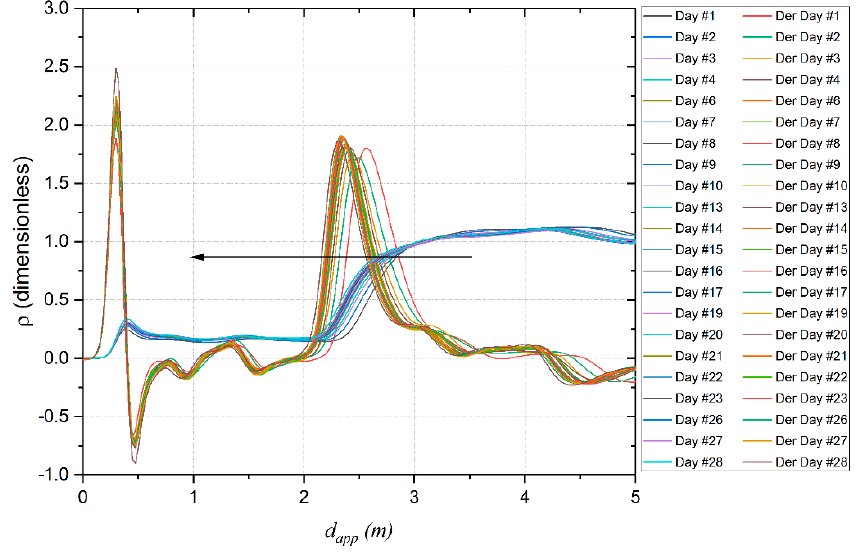
Figure 10. Reflection coefficient as a function of the apparent distance and the related derivative.